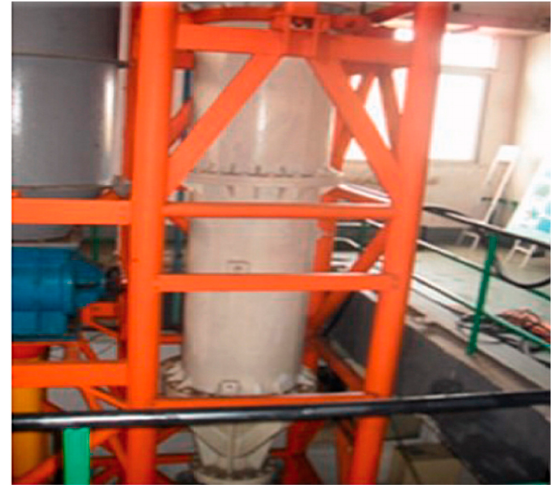
Figure 3. Test site diagram.